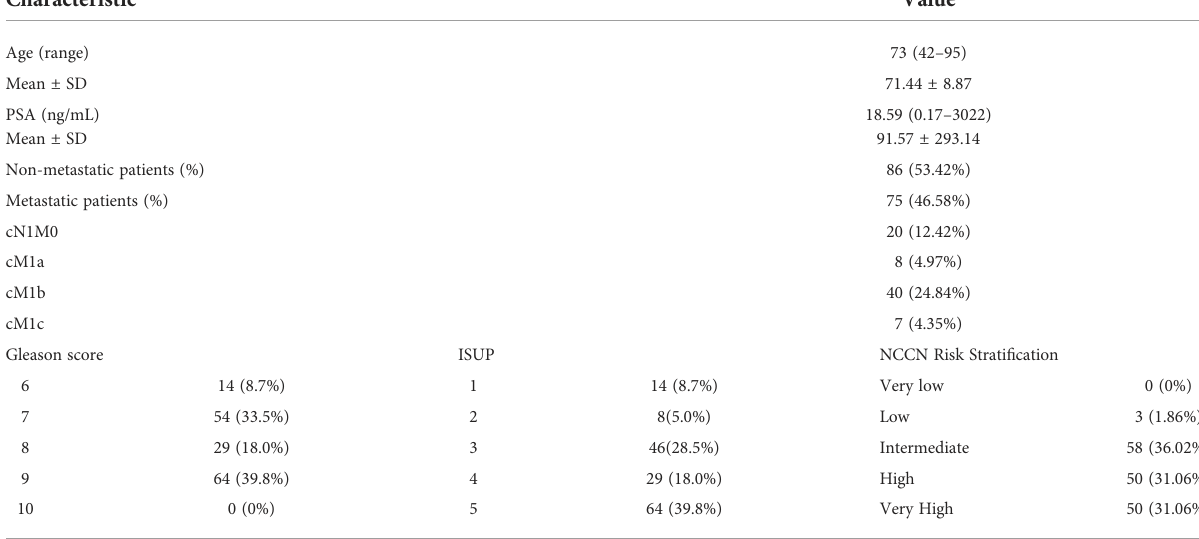
TABLE 1 Demographic and clinical characteristics of the primary prostate cancer patients.